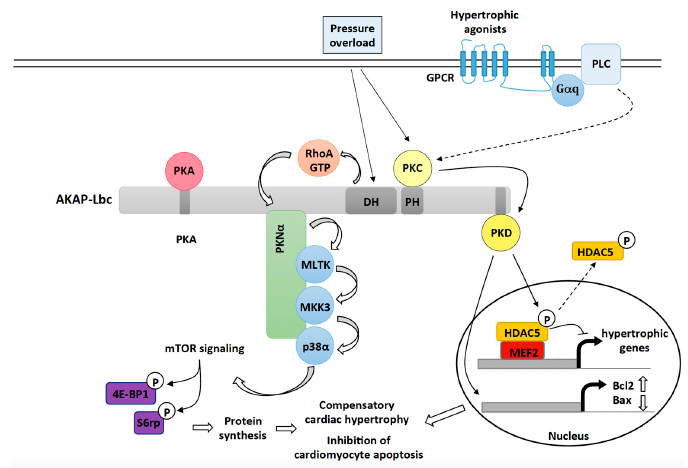
Figure 1. The role of the AKAP-Lbc signaling complex in mediating compensatory cardiac hypertrophy and cardiac protection in response to hemodynamic and neurohumoral stresses. Upon pressure overload, AKAP-Lbc promotes the formation of RhoA-GTP, which, in turn, triggers a signaling cascade involving anchored PKN α , MLTK, MKK3 and p38 α . Activated p38 α , through an unknown mechanism, enhances mTOR activity resulting in increased phosphorylation of 4E-BP1 and ribosomal protein S6 (S6rp), which leads to enhanced protein synthesis and cardiomyocyte growth. Pressure overload as well as activation of Gq-coupled receptors by hypertrophic agonists (ET-1, Angiotensin II) also promote the activation of AKAP-Lbc-anchored PKD1, which, in turn, phosphorylates HDAC5 and favors its nuclear export. As a result, MEF2 becomes activated and promotes transcription of hypertrophic genes. Activated PKD1 plays protective roles during compensatory hypertrophy by inducing the